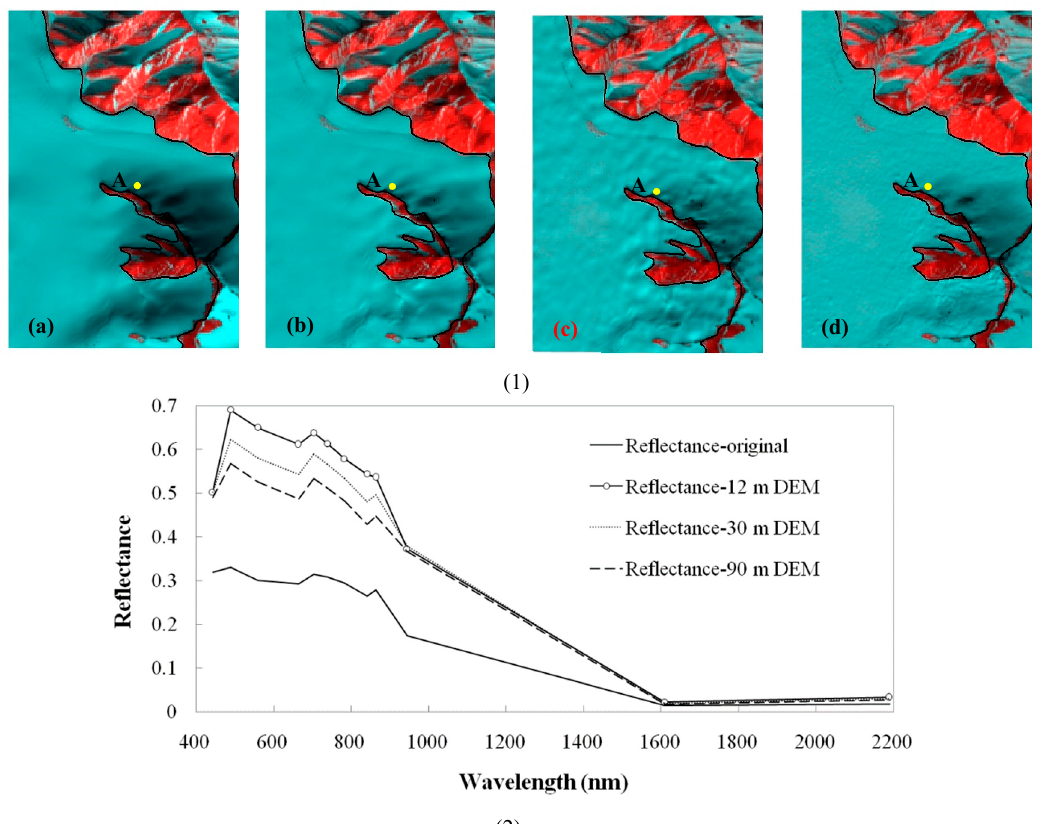
Figure 9. Comparative analysis of an original image with the results of topographic normalization on October 14, 2017, using three DEM resolutions. ( 1 ) False-color composite (RGB: bands 11, 4 and 3): ( a ) original image; ( b ) 90 m DEM; ( c ) 30 m DEM; ( d ) 12 m DEM. ( 2 ) Spectral reflectance curves for the original image and the images subjected to topographic normalization.